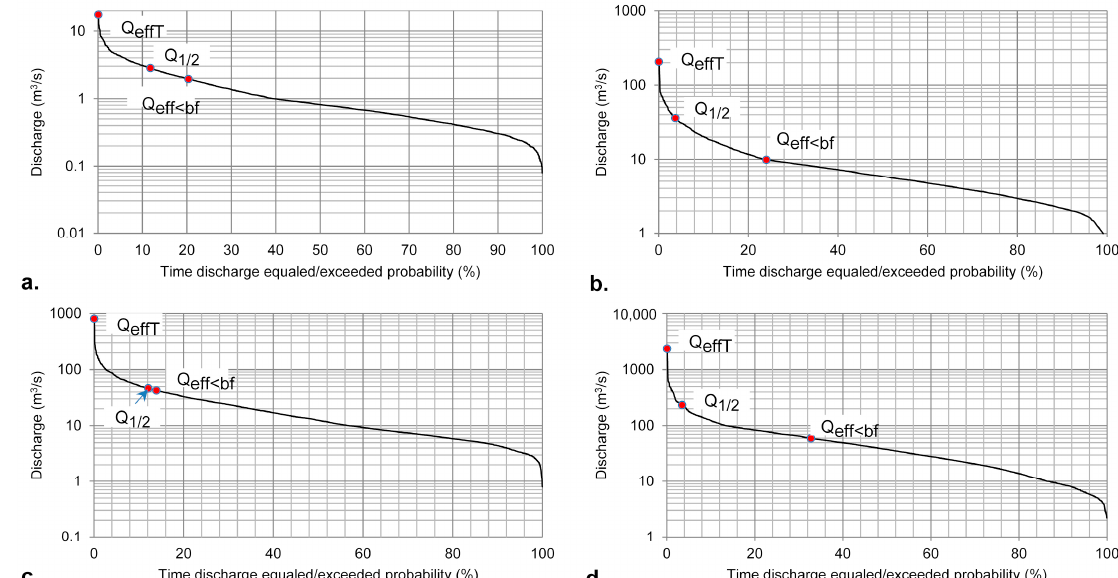
Figure 8. Q effT , Q eff<bf and Q 1/2 equalled/exceeded probability. ( a ) Lunca de Sus; ( b ) Goioasa; ( c ) Târgu Ocna; ( d ) Vrânceni. Ocna; ( d ) Vr â nceni.